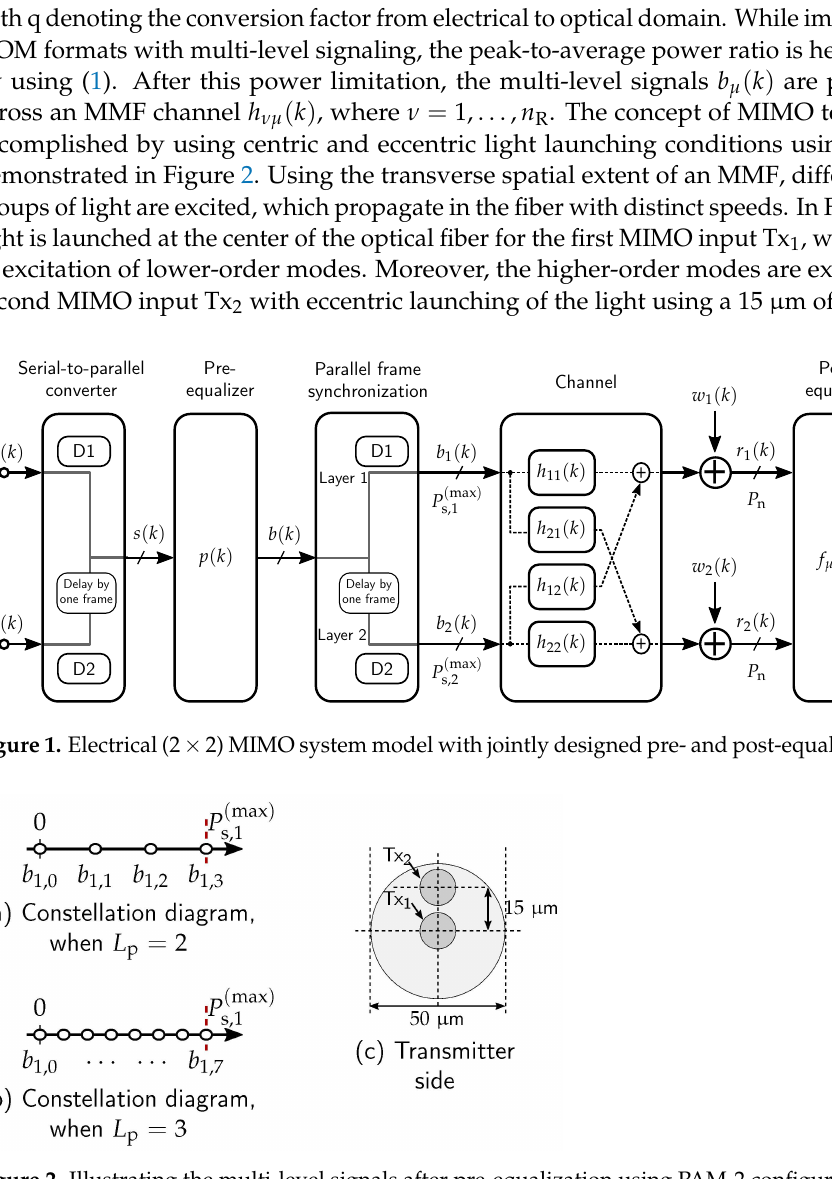
Figure 2. Illustrating the multi-level signals after pre-equalization using PAM-2 configuration, where: ( a ) L p = 2; and ( b ) L p = 3. At the transmitter, the light launching conditions into the optical fiber core are included in ( c ), which represents the centric 0 µ m and eccentric 15 µ m light launching conditions for two MIMO inputs Tx 1 and Tx 2 ,